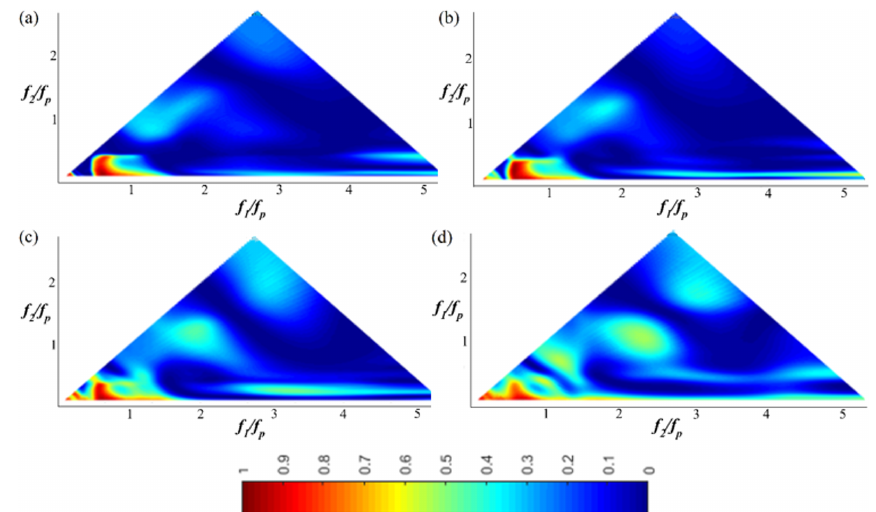
Figure 7. The wavelet-based bicoherence spatial evolution on the flat bottom for the JONSWAP ( γ = 3 . 3) wave train (Test 5). (a) x = 4m; (b) x = 6m; (c) x = 8m; (d) x = 9 . 6.